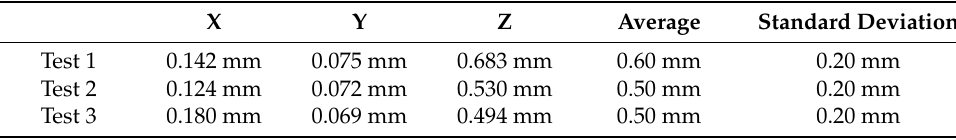
Table 6. Trajectory RMSE error for V-type butt joint.